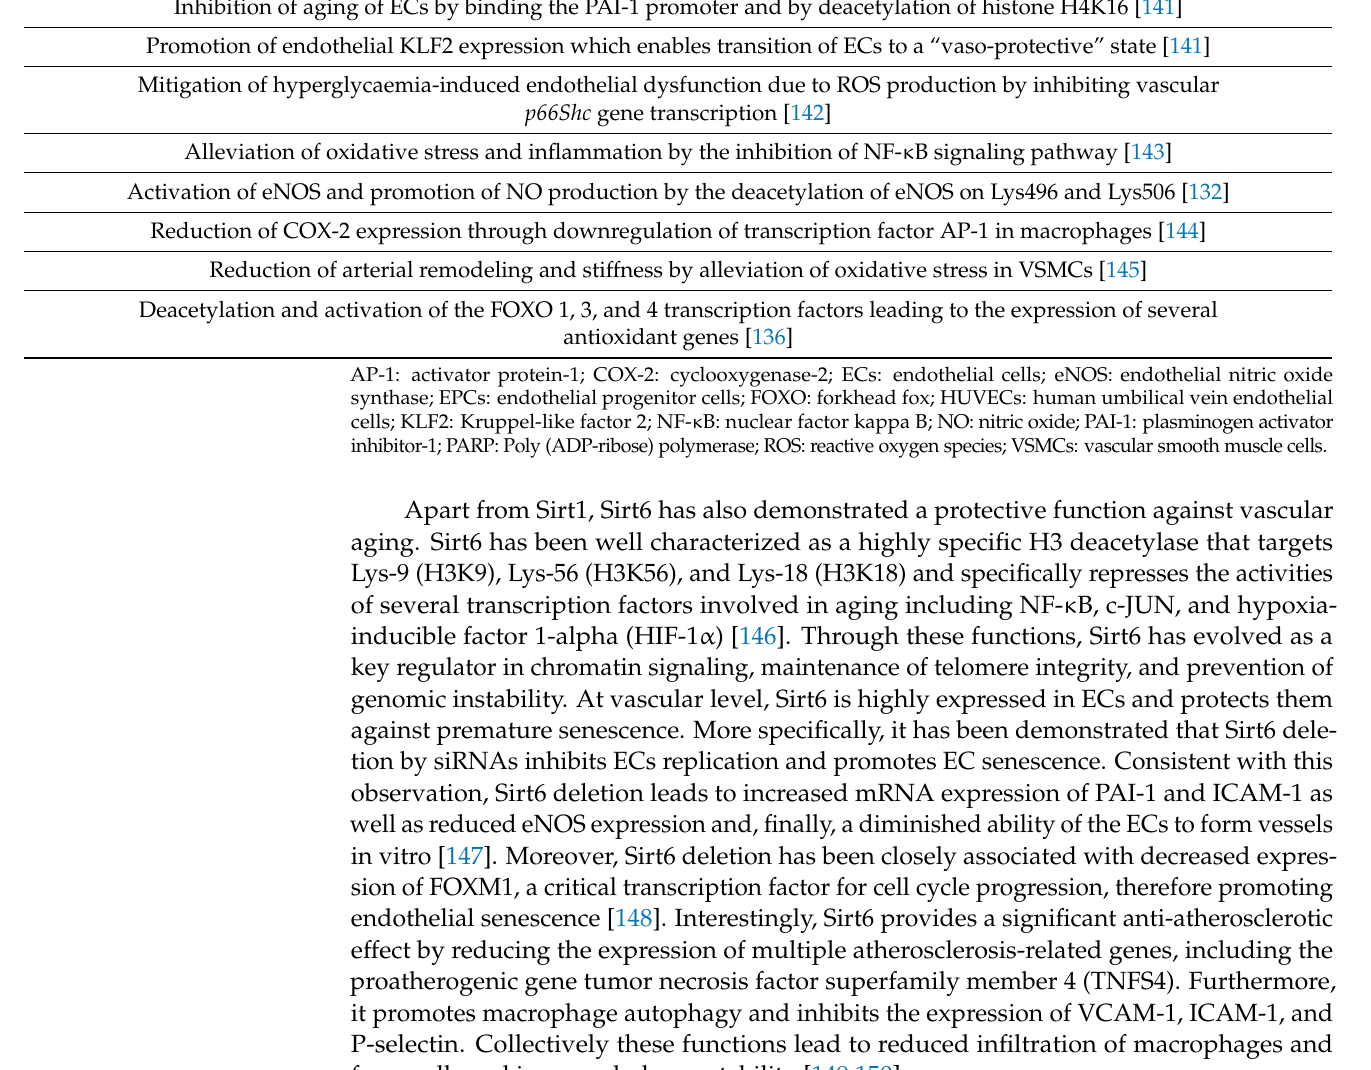
Table 2. Beneficial mechanisms through which SIRT1 upregulation protects against vascular aging. Recruitment of EC migration [139] Delay of the aging and dysfunction of EPCs [140] Inhibition of aging of ECs by binding the PAI-1 promoter and by deacetylation of histone H4K16 [141]